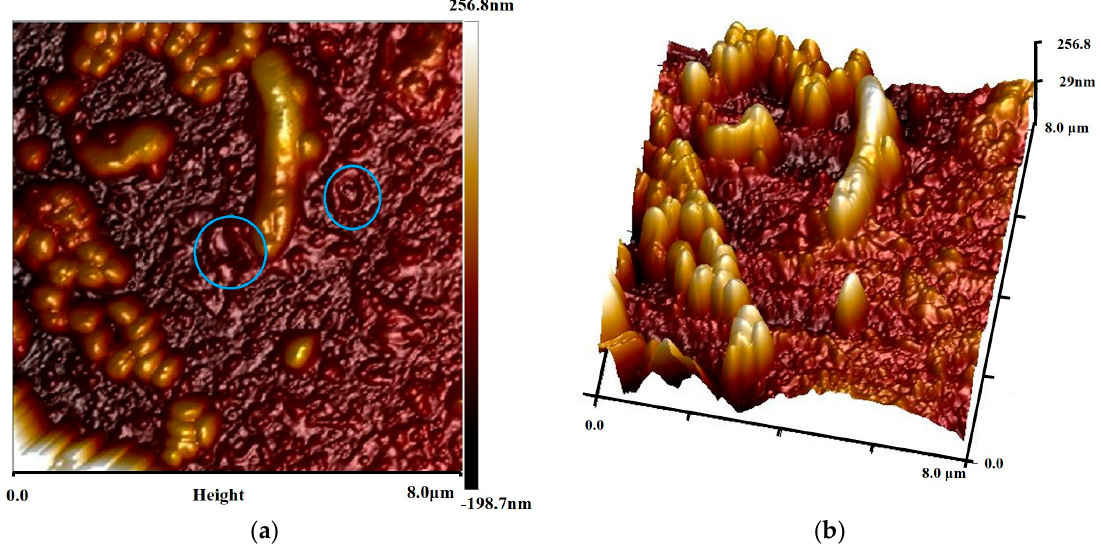
Figure 7. AFM ( a ) 2D and ( b ) 3D images of bacterial adsorption at 8 h.